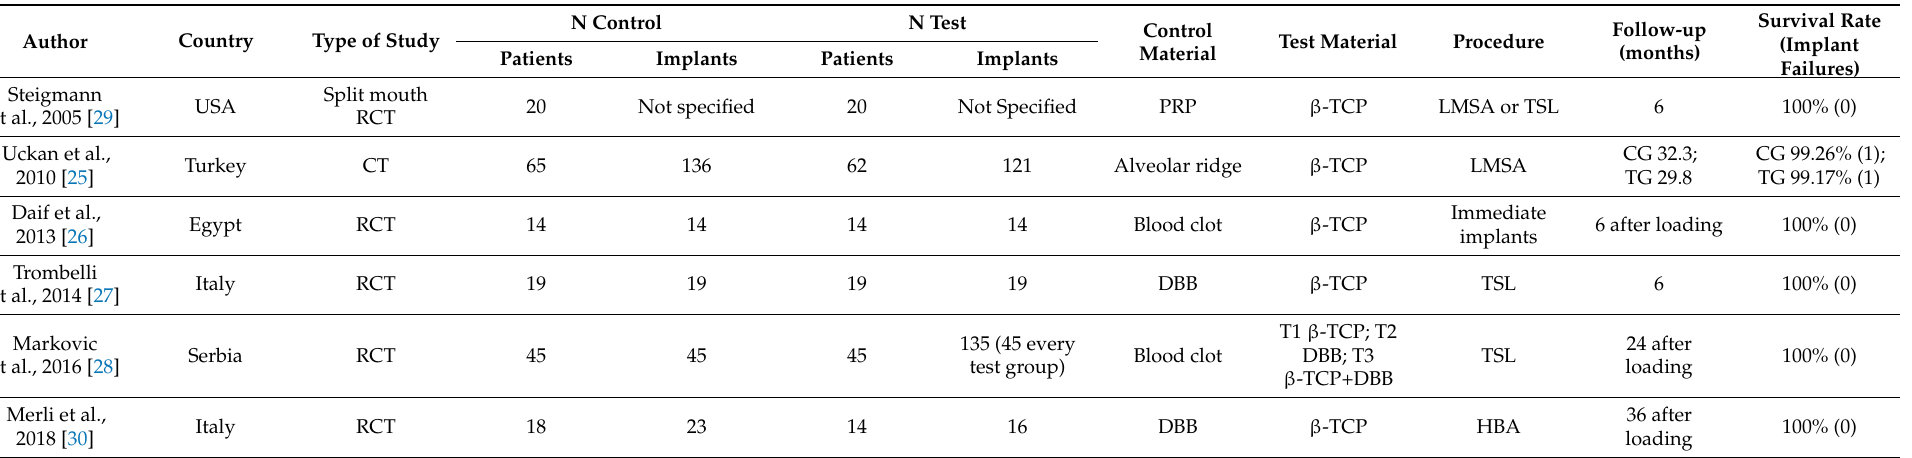
Table 1. Summary of the included comparative studies. Abbreviations: β -TCP, beta-tricalcium phosphate; CG, control group; CT, clinical trial; DBB, deproteinized bovine bone; HBA, horizontal bone augmentation; LMSA, lateral maxillary sinus augmentation; PRP, platelet-rich plasma; RCT, randomized clinical trial; TG, test group; TSL, transcrestal sinus lift.